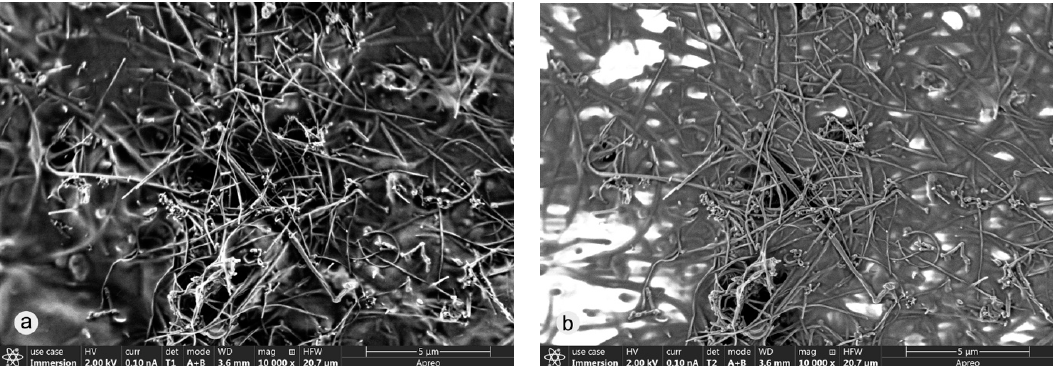
Figure 3. Bucky paper imaged in the SEM with the ( a ) BSE detector (T1) and the ( b ) SE detector (T2) detector. Note the difference between the material and topography contrast provided by the back-scattered and secondary electrons, respectively. Moreover, the pores in the microfiltration membrane are clearly visible in ( b ).